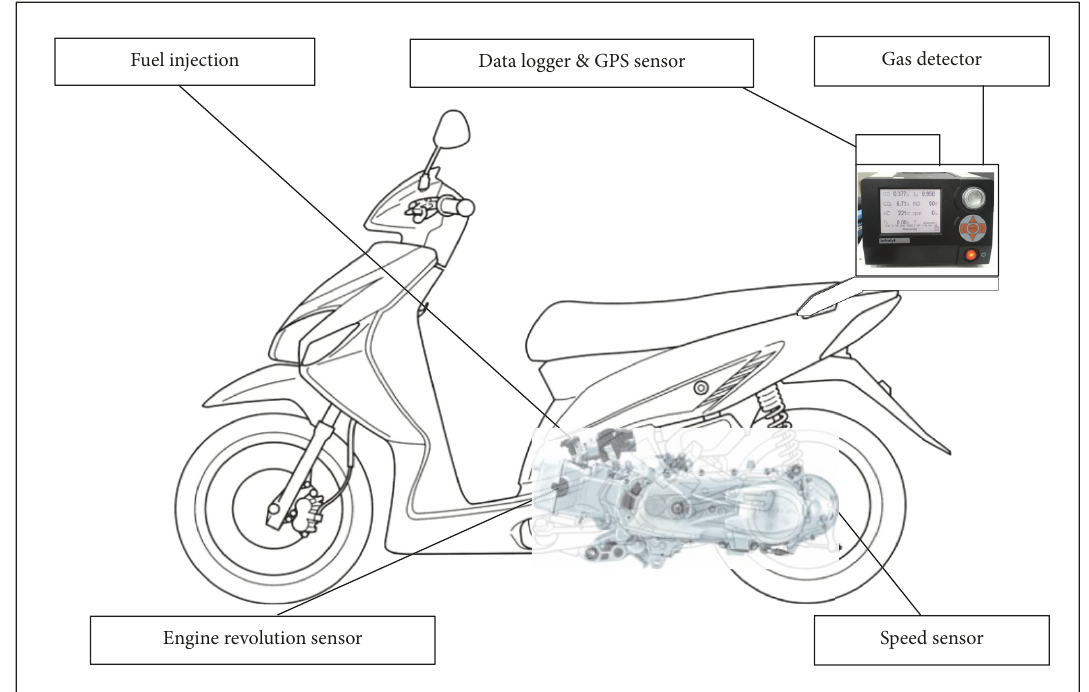
Figure 1: Component units of developed onboard measurement system.